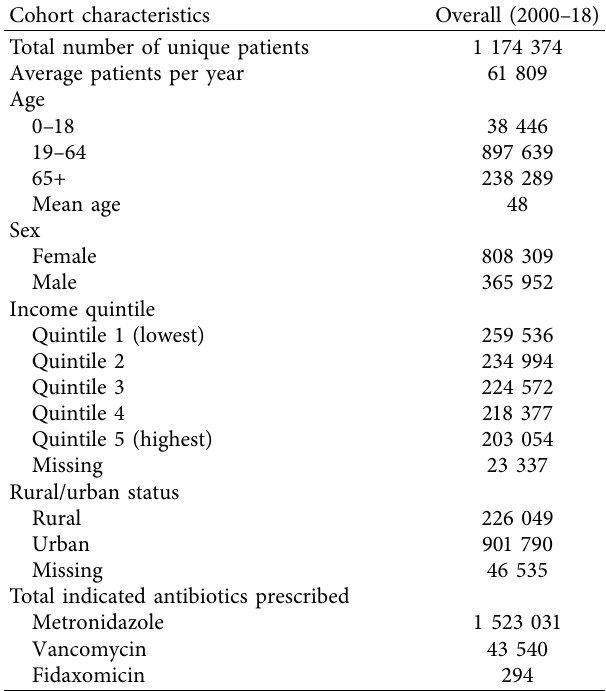
Table 1: Cohort characteristics, overall data from 2000 to 2018. Cohort